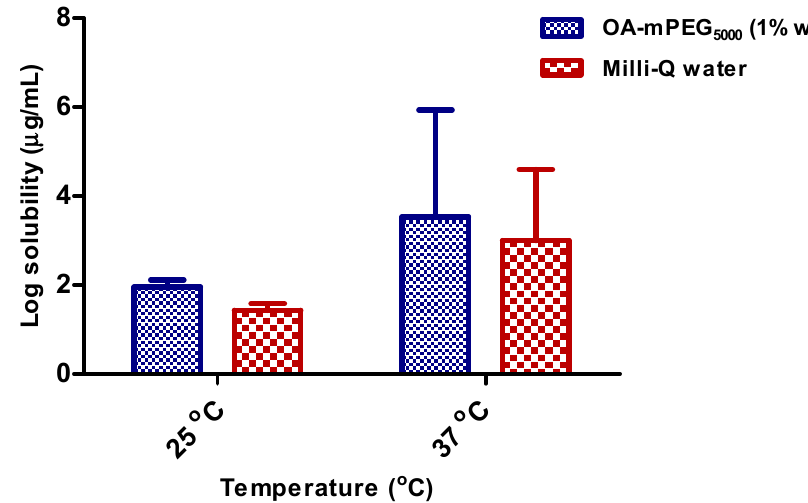
Figure 2. Log solubility of furosemide in OA-mPEG5000 and milli-Q water at 25 °C and 37 °C (n =